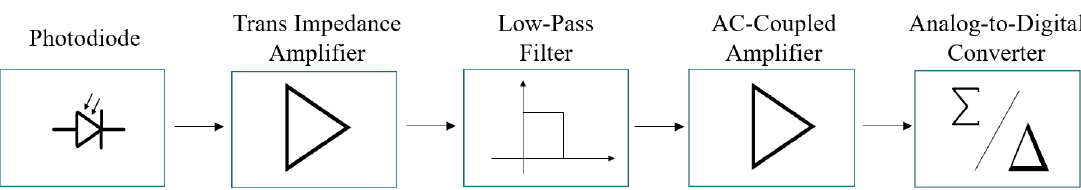
Figure 7. A block schematic representation of the receiver